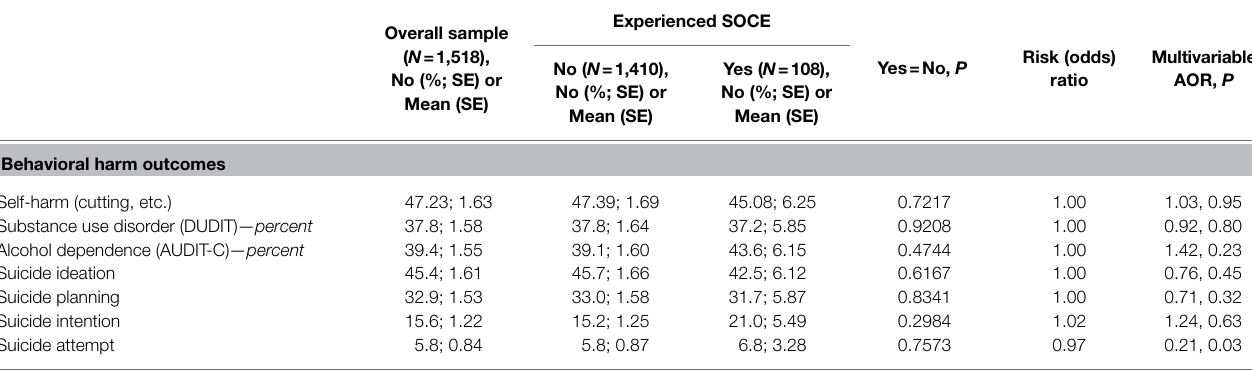
TABLE 3 | Unadjusted means and risk ratios, and adjusted AORs, showing current behavioral harm by experiencing SOCE, counts, and weighted proportions: probability sample of sexual minorities, United States, 2016–2018 ( N = 1,518). Overall sample ( N =